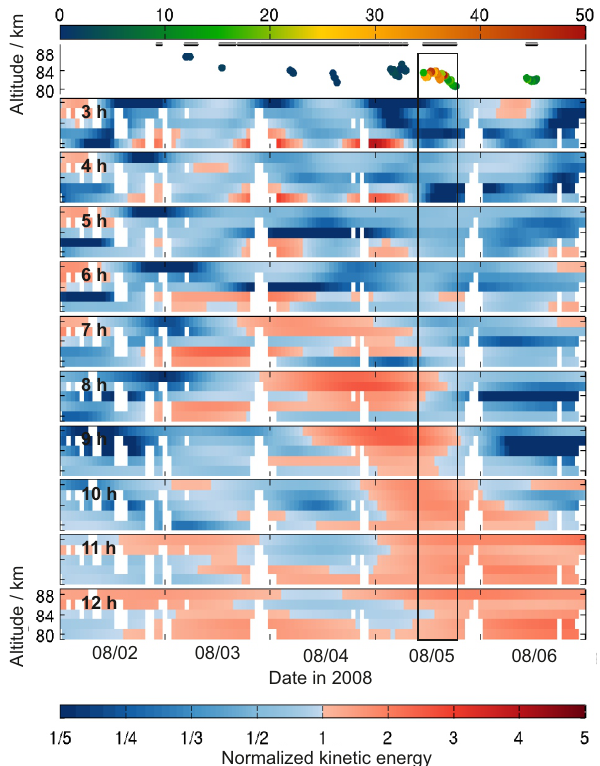
Fig. 7. NLC and gravity wave data for an exceptionally bright NLC on 5 August 2008. The top panel shows the NLC height and colour- coded the maximum backscatter coefficient β max . Times of lidar measurement are indicated by the black line above the NLC data. The panels below show the height-time cross-section of normalized kinetic energy for periods between 3h and 12h.